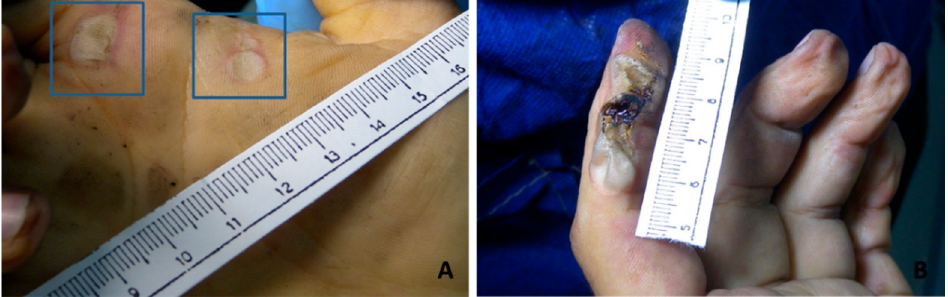
Figure 1. Macroscopic findings. Electrical lesions on the right palm ( A insert) from low voltage; electric lesion of the dorsal face of the second finger on the left hand from high voltage ( B ).